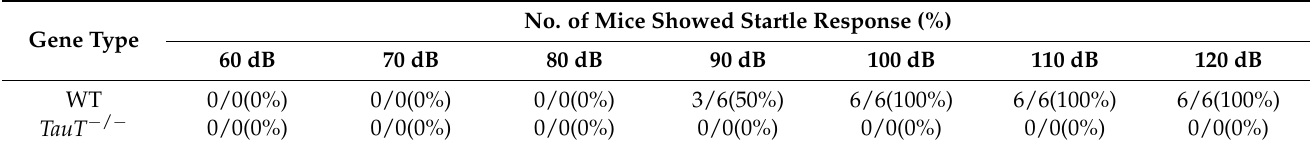
Table 1. Startle response test. Numbers of mice showing a startle response to the startle pulse. Gene Type